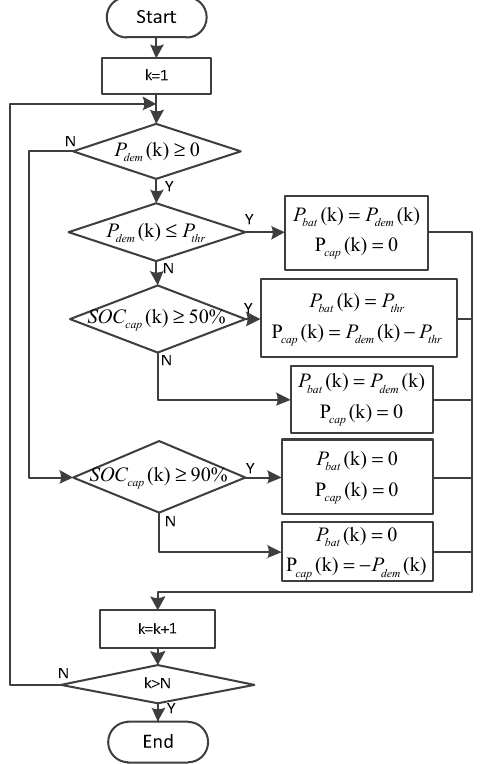
Figure 13. The implementation process of rule-based strategy.